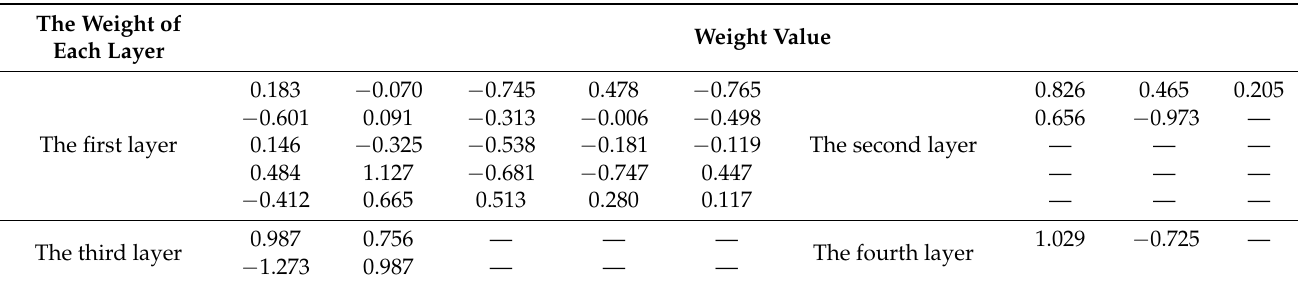
Figure 6. Convergence of loss function of reducer transmission accuracy error. Table 3. Optimal weights.